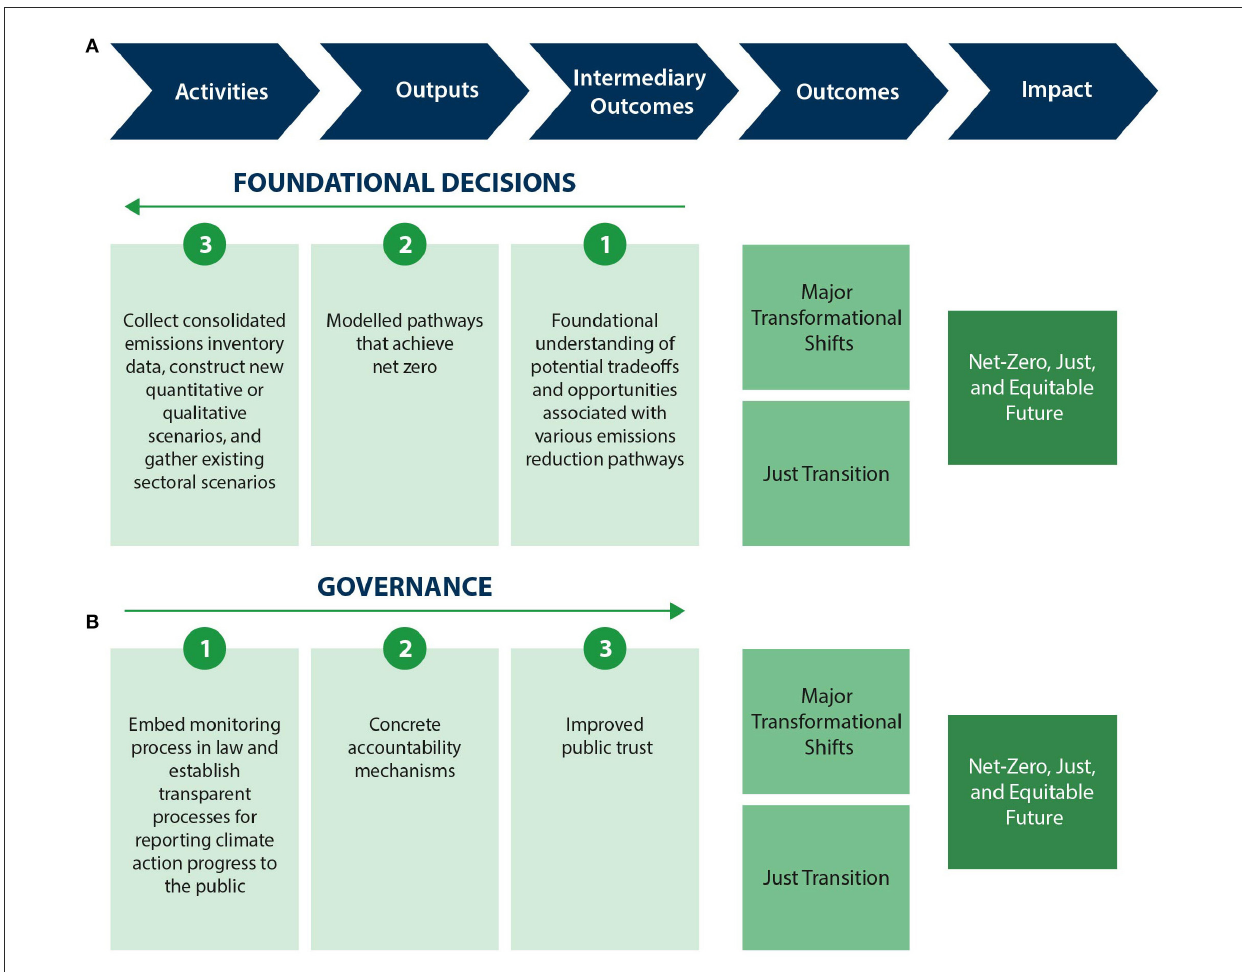
FIGURE2 Possible use-cases of the logical framework for net-zero climate action. (A) Depicts a right-to-left backcasting approach where countries identify intermediary outcomes they would like to achieve and then hypothesize about the respective outputs that would support progress toward the intermediary outcome, as well as the activities necessary to achieve the output. (B) Depicts a left-to-right approach where countries take stock of activities they have already implemented and then set goals for desired outputs and resultant intermediary outcomes. These two use-cases are not exhaustive of all possible uses for the logical